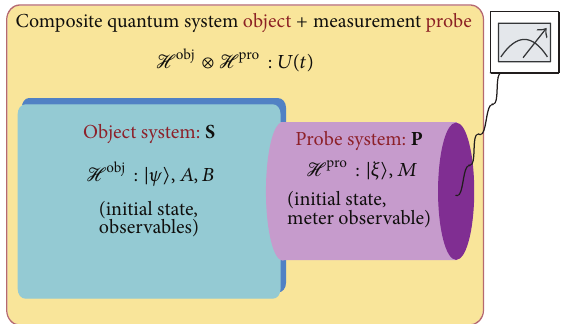
Figure 3: An indirect measurement model for apparatus A measur- ing an object system S , defined on Hilbert space H obj , is specified by a quadruple ( H pro , |𝜉⟩, 𝑈(𝑡),𝑀) .